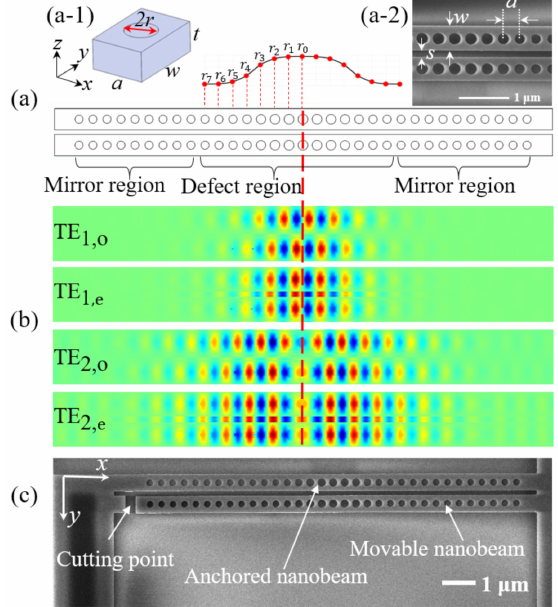
Figure 1. Cavity structure and simulated optical mode field profiles. ( a ) Schematic of the coupled photonic crystal nanobeam (PCN) cavity, with the unit cell section shown in ( a-1 ), dimensions: Si layer thickness t, lattice constant a, width w, and hole radius r, and with the SEM photograph of the cavity center shown in ( a-2 ), dimension: gap separation s; ( b ) FDTD simulation of the first two orders of the electrical field (Ey) mode profiles, with the center dotted red line indicating the location of the center air hole; ( c ) top-view SEM image of the coupled PCN cavity with the slot gap of 117 nm. The proposed coupled PCN cavity is fabricated on a silicon-on-substrate (SOI) wafer with a 0.22 µ m thick silicon layer and a 3 µ m buried silicon dioxide layer. Figure 1c shows the scanning electron microscope (SEM) images of the fabricated nanobeam cavity. In the fabrication process. The cavity pattern is first defined as a 220 nm thick E-beam resist (ZEP520) layer using electron beam lithography (EBL) and then transferred to the silicon layer by inductively coupled plasma (ICP) etching. Finally, the suspended nanobeam is released by wet etching using a buffered hydrofluoric acid (BHF, BOE 6:1) solution to remove the buried oxide layer beneath the silicon device